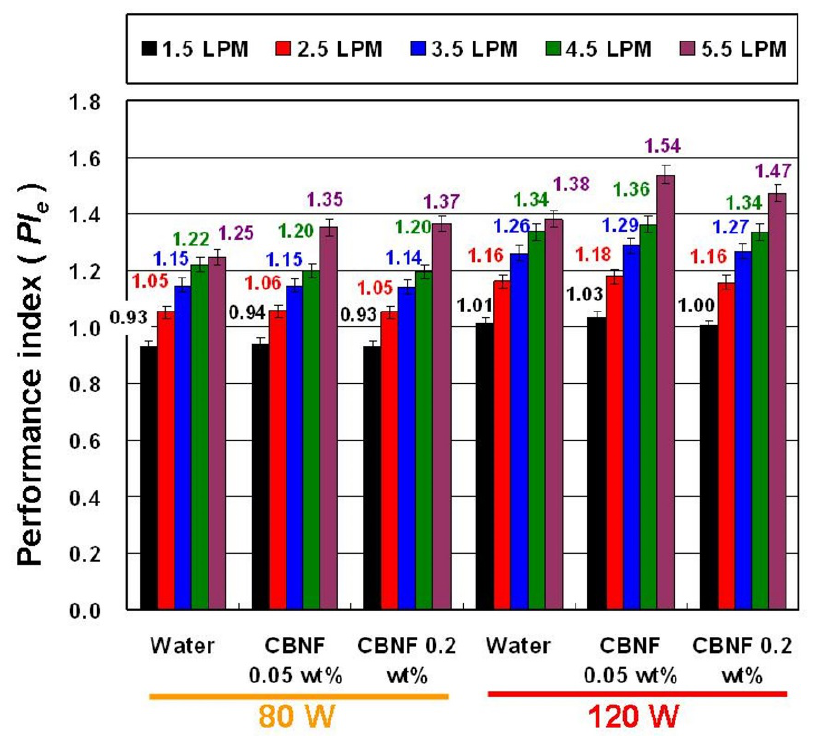
Figure 10. The PI e of test samples for THE system at various experimental parameters.